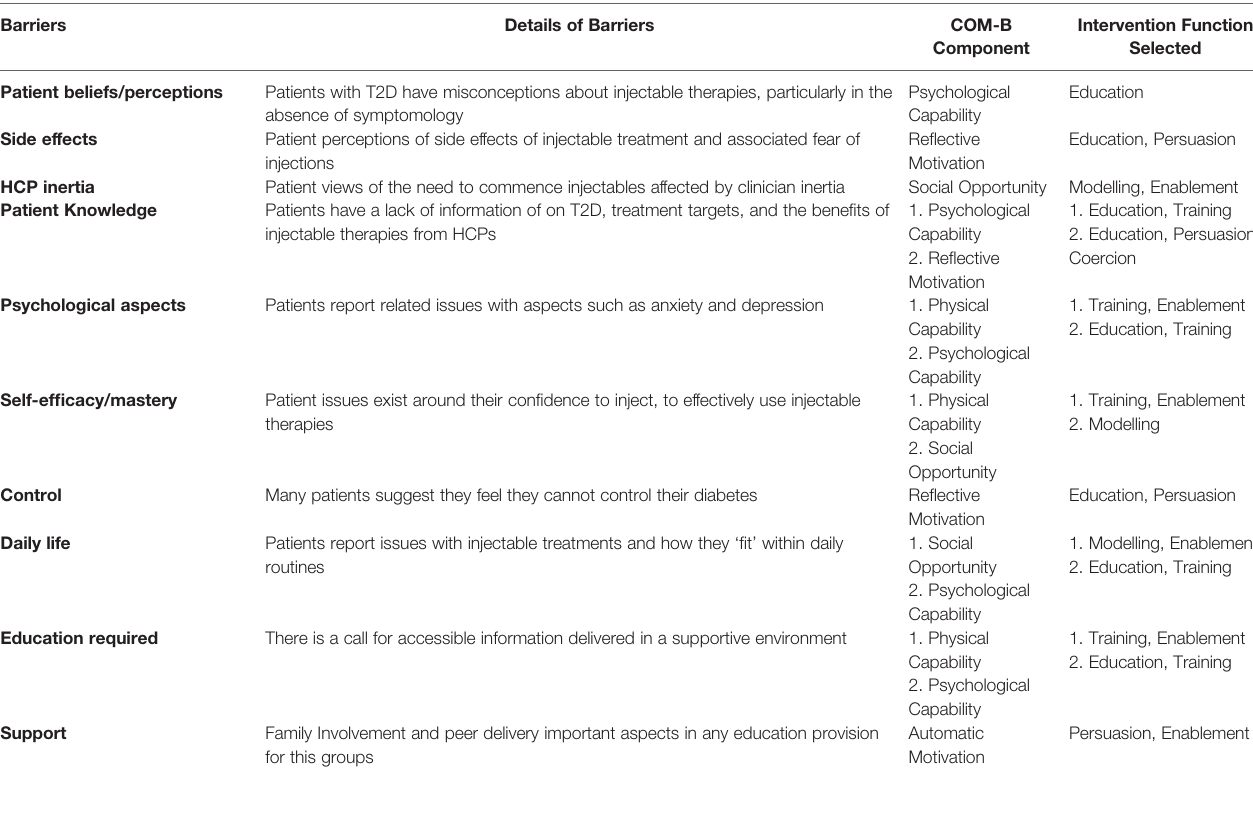
TABLE 1 | Mapping barriers to initiation/adherence of injectable treatments.